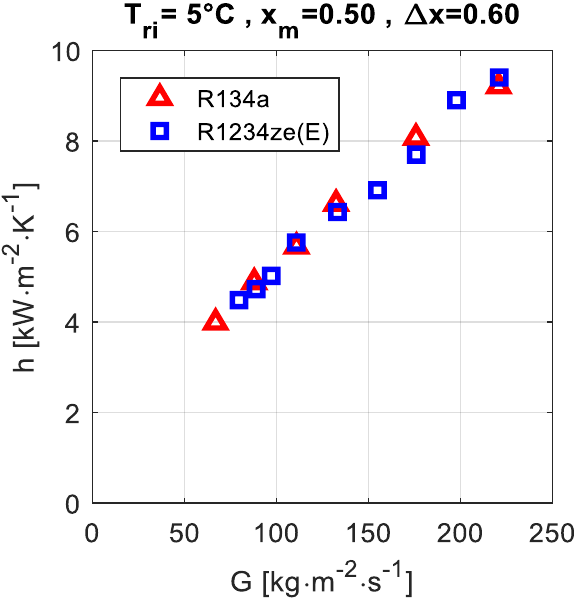
Figure 7. Heat transfer coefficient as a function of the mass flux.